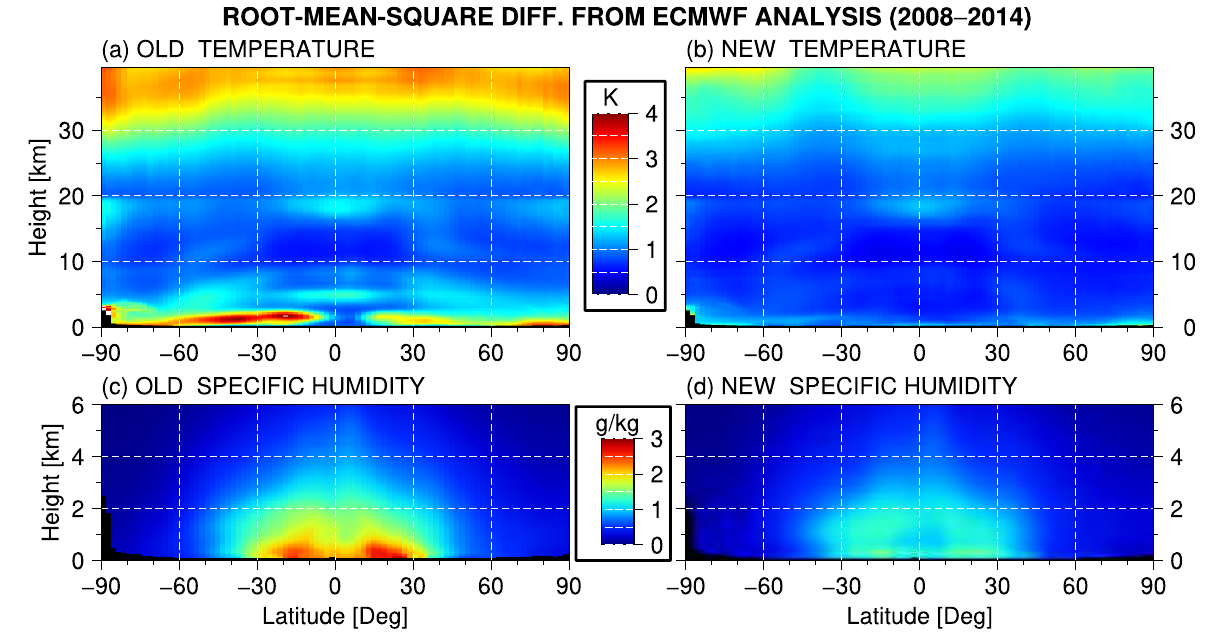
Figure 9. Root-mean-square differences of 1DVAR retrievals from operational ECMWF analysis: ( a , b ) temperature (°C) and ( c , d ) specific humidity (g kg −1 ). Left panels, ( a , c ), are for the previous 1D- Var version (denoted OLD), while right panels are for the new 1D-Var (denoted NEW) described in this paper.